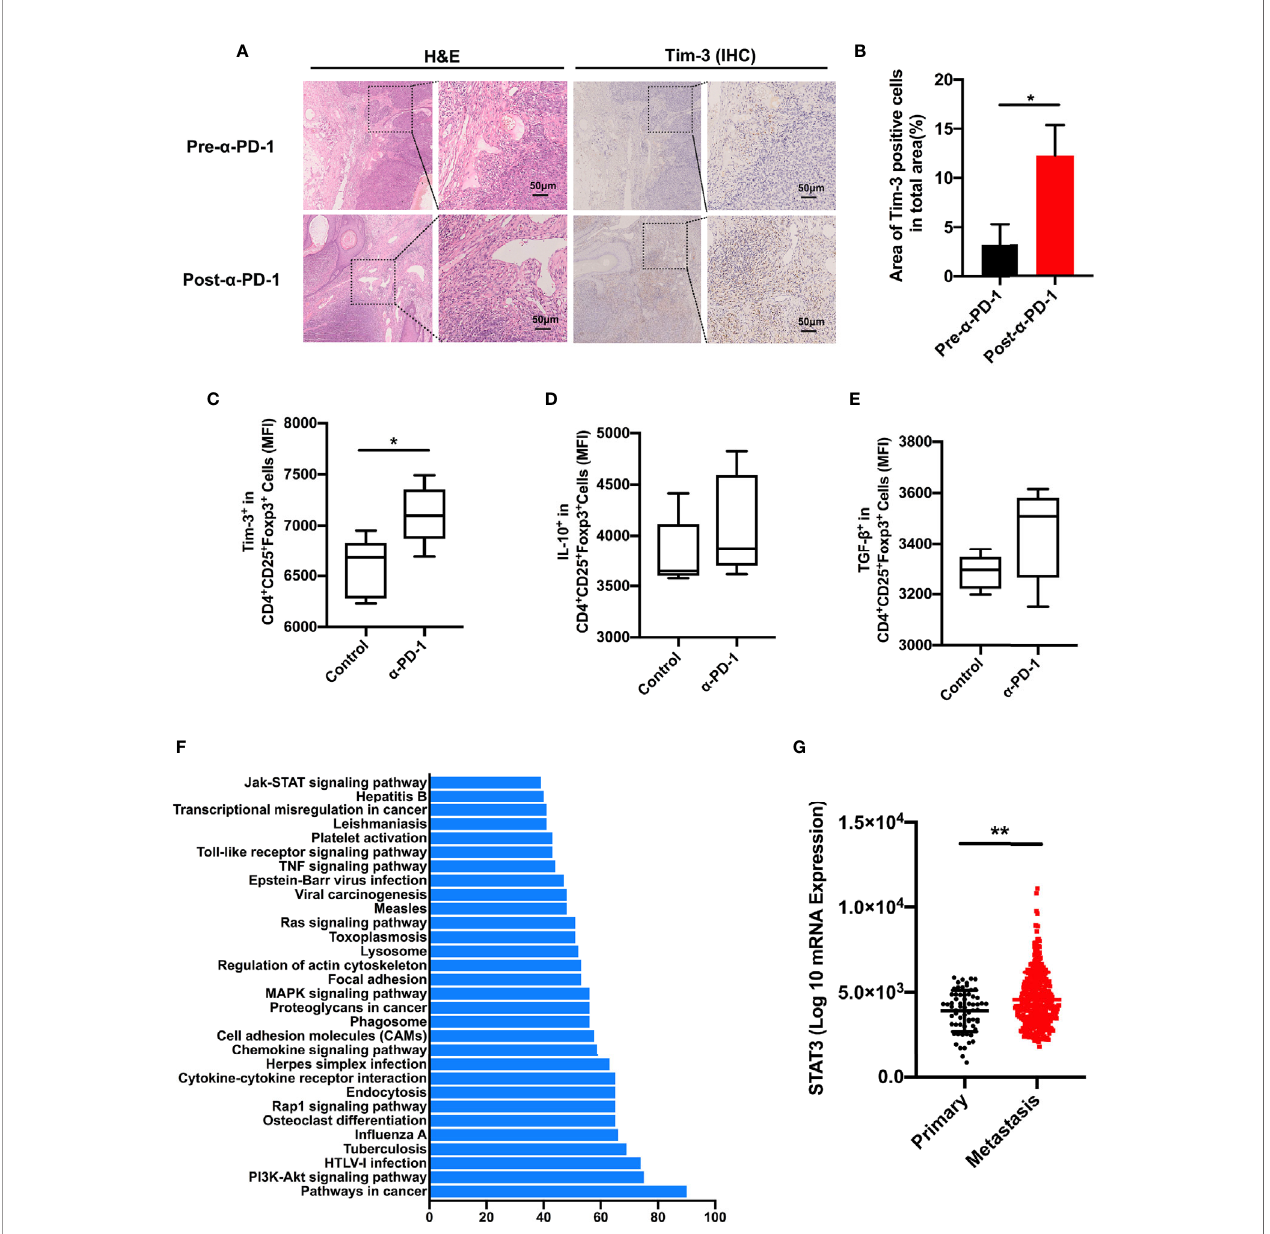
FIGURE 3 | STAT3 pathway involved in PD-1 expression. (A, B) H&E and IHC for Tim-3 expression levels in anti-PD-1 resistance melanoma patients ’ tissue samples (n=3). Representative images from three patients displayed positive Tim-3 staining in stromal regions (A) . Scale bar = 50 m m. Quanti fi cation of positive cells in tumor sections using ImageJ software (B). Signi fi cance was calculated with a t -test, and all data are presented as the means ± SEM. (C, E) Tim-3 expression (C) , IL-10 (D) , and TGF- b (E) production in Treg cells were investigated by fl ow cytometry after anti-PD-1 treatment in the B16-F10 melanoma mouse model. (F) Signi fi cantly enriched pathways terms of differentially expressed genes in the PD-1 high and PD-1 low sub-populations in melanoma. The top 30 functional and signaling pathway enrichment were conducted using the online website DAVID. (G) STAT3 expression in primary and metastatic melanoma patients from the TCGA dataset. * p ≤ 0.05 and ** p ≤